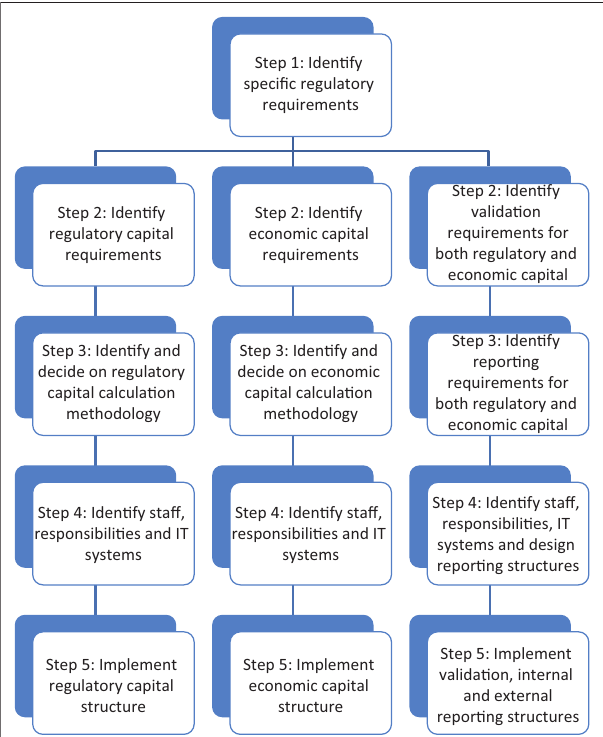
FIG URE 11: Recommended implementation framework.